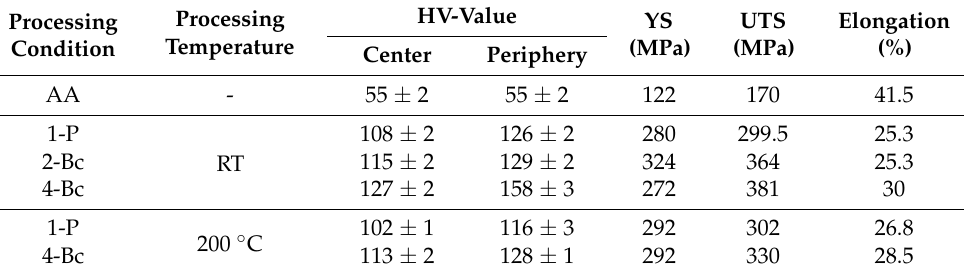
Table 3. Mechanical properties of commercial pure Cu processed via